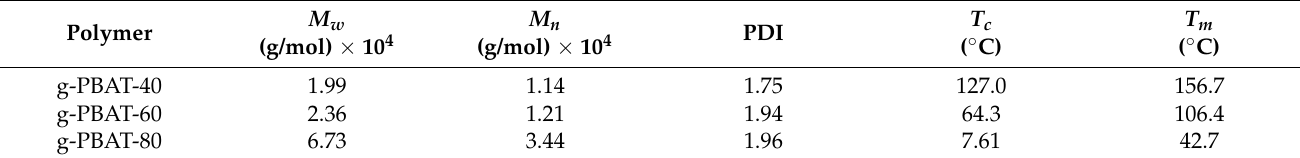
Table 2. Molecular weight and crystallization temperatures of grafted